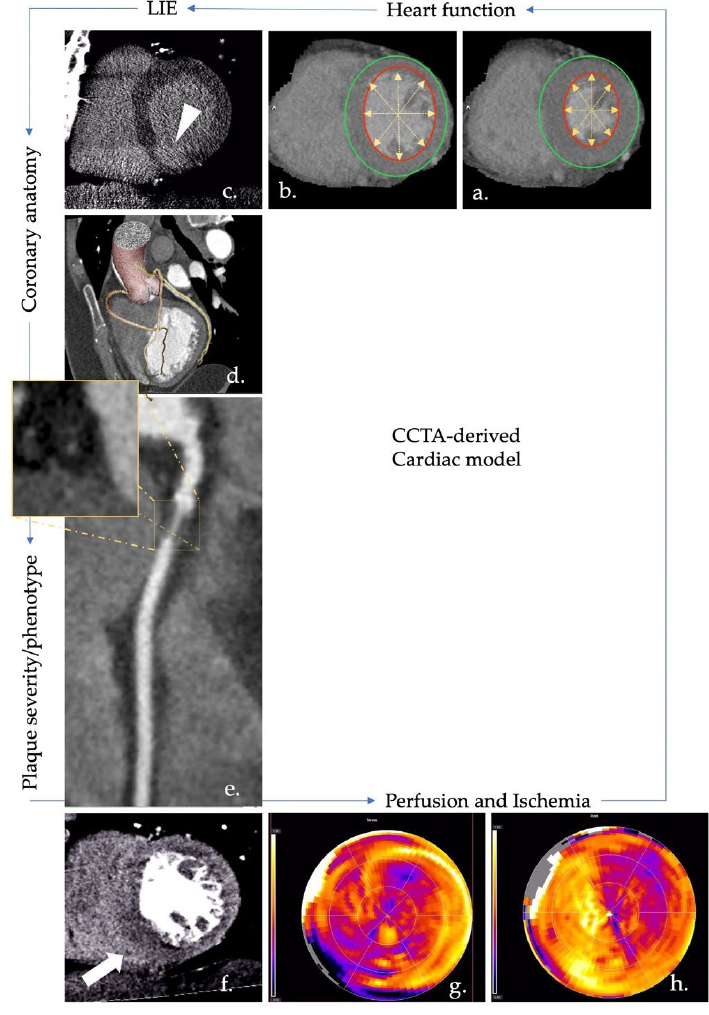
Figure 3. CCTA biomarkers useful for a proper definition of HF patient. Typically, CCTA is a well- known tool for description of cardiac anatomy; in image ( d ), volume-rendered reconstruction of aortic root and coronary anatomy superimposed onto an MIP reconstruction of cardiac chambers in a similar projection. CCTA allows (i) an accurate detection of coronary stenosis; (ii) a good definition of the degree of stenosis; (iii) an optimal definition of plaque phenotype. In image ( e ), a severe non- calcified stenosis in proximal RCA; the plaque shows a prevalent lipidic composition. High-temporal resolution exhibited by the latest CT scanners also allows the complete cardiac cycle with a relatively low-dose exposure to be acquired; the retrospective analysis could be useful for the estimation of cardiac volumes and function. Images ( a , b ) show the SA view of the same plane in diastolic and systolic phase: dedicated software can automatically derive volume and function from the contouring of the entire chamber, similar to CMR. Using vasodilator agents, CCTA also allows the evaluation of myocardial perfusion, both with static or dynamic acquisition, mainly depending on the technology of the scanner. Images ( f – h ) show a stress acquisition (image ( f )) and colorimetric map of stress and rest acquisitions (images ( g , h ), respectively). As highlighted by the white arrow, reversible ischemia is detected in the inferoseptal wall on the basal and medial plane. Lately, great interest has also been derived from tissue characterization, although mainly through the use of dual-energy, which allows the definition of an iodine map. In image ( c ), an example of LIE with late acquisition revealing a subendocardial iodine enhancement related to a previous MI. CCTA: coronary computed tomography angiography; HF: heart failure; MIP: multiplanar image projection; RCA: right coronary artery; CT: computed tomography; SA: short axis; CMR: cardiac magnetic resonance; LIE: late iodine enhancement; MI: myocardial